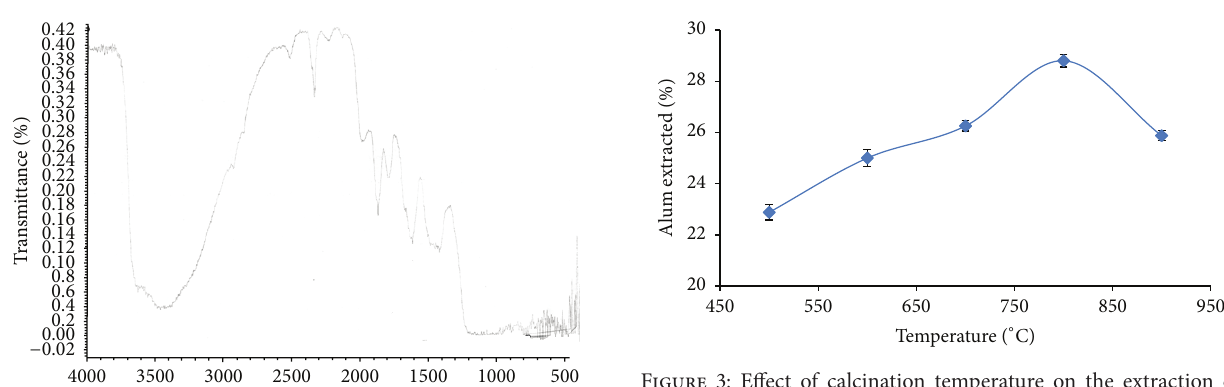
Figure 3: Effect of calcination temperature on the extraction of aluminum sulphate (time: 60 min; particle size: 100 𝜇 m; error bar = ± SD; and 𝑛 = 3 ).